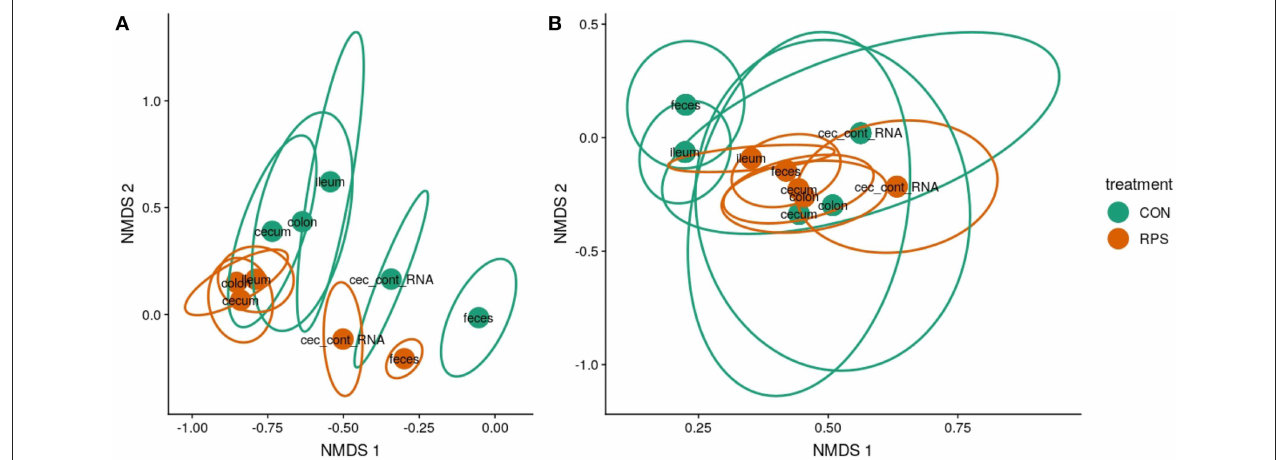
FIGURE 2 | Bacterial community structure in RPS-fed pigs (orange) compared to CON-fed pigs (green) at day 21. Nonmetric multidimensional scaling (NMDS) ordinations of 16S rRNA gene-based Bray-Curtis dissimilarities calculated from rarefied OTU tables (clustered at 97% identity) (A) and but gene-based Bray-Curtis dissimilarities calculated from rarefied OTU tables (clustered at 97% identity). (B) Points indicate group centroids, from discrete gut locations as labeled. Centroids represent the approximate average community composition, and ellipses show standard error around this average. “Ileum” = ileal mucosa, “cecum” = cecal mucosa, “colon” = colonic mucosa and “Cec_cont_RNA” = RNA from cecal